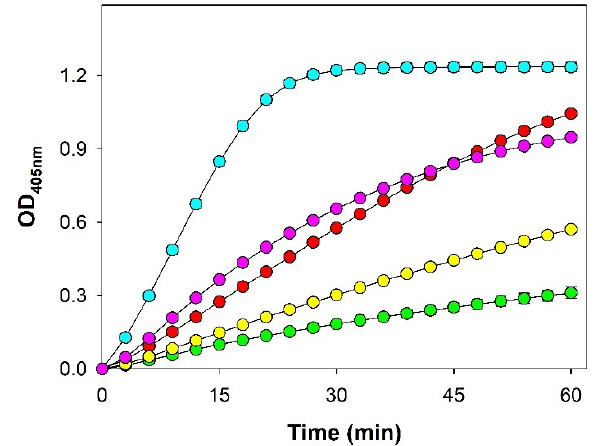
Figure 6. Effect of additional ions on PPA activity. The enzyme activity was measured as the absorption of the solution at 405 nm, in absence of ions (green circles), in presence of sodium lactate (yellow circles), NH 4 NO 3 (purple circles), Ca(NO 3 ) 2 (red circles), Ca(NO 3 ) 2 and NaCl (cyan circles).